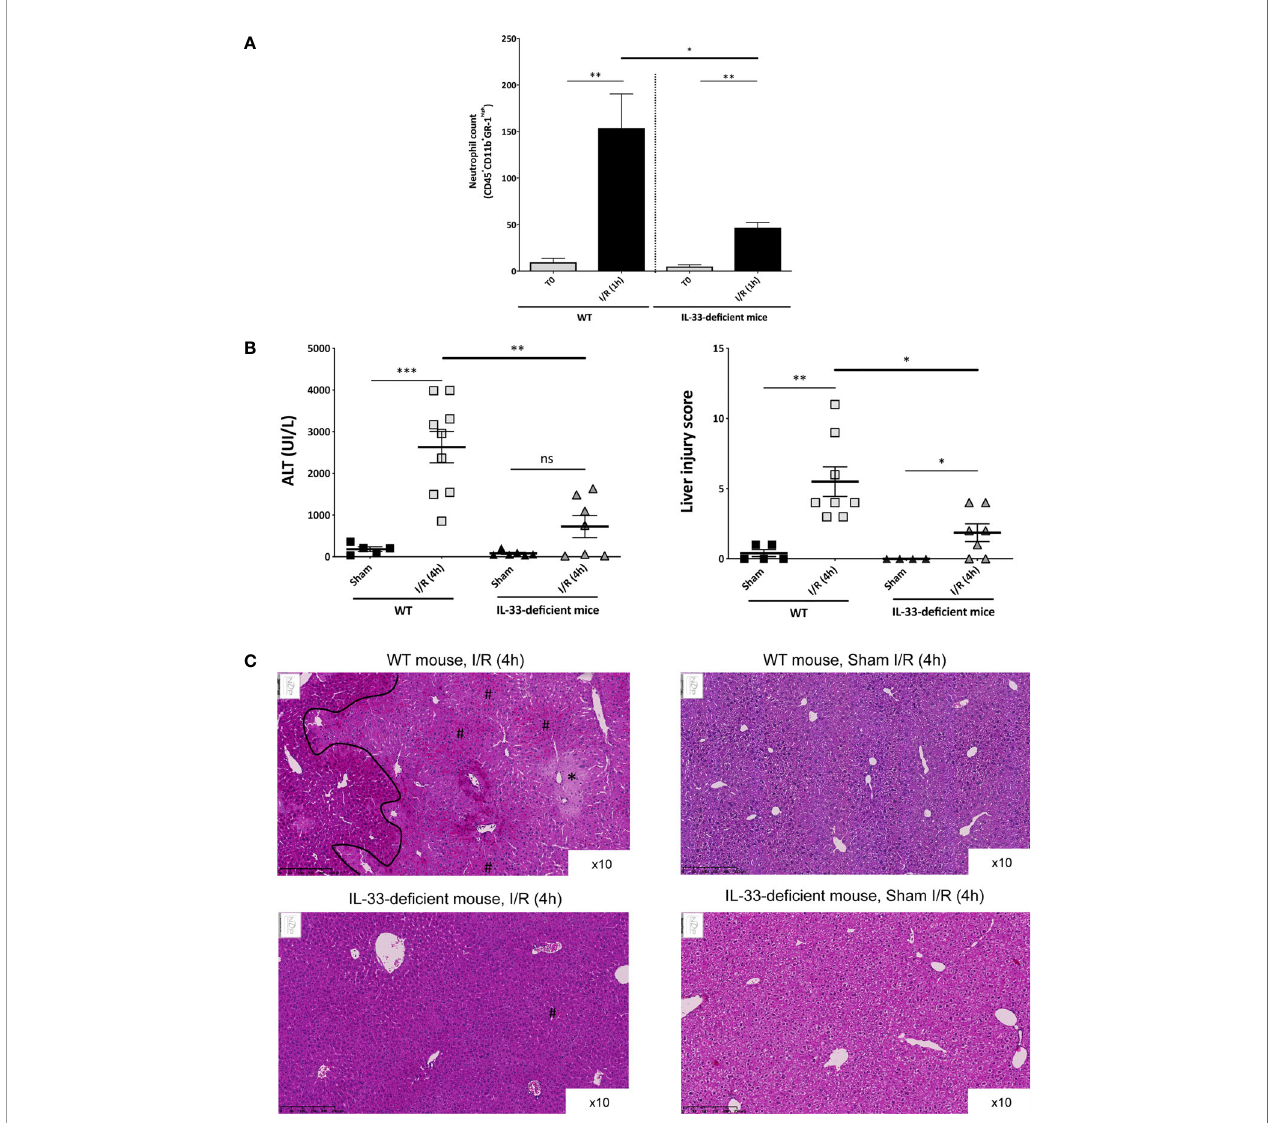
FIGURE 2 | Early recruitment of in fl ammatory cells and subsequent I/R injury after reperfusion depends on endogenous IL-33 and is responsible of I/R injury (mouse model). (A) Neutrophil count in the clamped liver lobes of WT and IL-33 – de fi cient mice, before clamping (T0) and after 1 h of reperfusion (I/R (1 h)). Immunoin fl ammatory cells were identi fi ed by fl ow cytometry, and results are displayed in absolute numbers per millgram of liver. Mean ± SEM, two-tailed Mann-Whitney U test, n = 4 – 11 mice per group. ns, not signi fi cant; * p < 0.05; ** p < 0.001. (B , left) Plasma levels of ALT (UI/L) in WT (left) and IL-33 – de fi cient mice (right) in Sham animals and after 4 h of reperfusion. Mean ± SEM, two-tailed Mann-Whitney U test, n = 5 – 9 mice per group. (B , right) Liver injury score in WT (left) and IL-33 – de fi cient mice (right) in Sham animals and after 4 h of reperfusion (I/R (4 h)). Mean ± SEM, two-tailed Mann-Whitney U test, n = 5 – 10 mice per group. (C) Tissue sections after paraf fi n embedding and HPS staining. (Top, left) Clamped liver of a WT mouse after 4 h of reperfusion at ×10 magni fi cation. *Shows an area with suffering hepatocytes; # shows an area with sinusoidal congestion and dilatation (red blood cells in sinusoidal spaces). On the left of the demarcation line, lesions are less intense. (Top, right) Liver of a Sham WT mouse at ×10 magni fi cation showing a normal liver. (Bottom, left) Clamped liver of an IL-33 – de fi cient mouse after 4 h of reperfusion at ×10 magni fi cation. There is no necrotic area; only some minor sinusoidal congestion can be identi fi ed (number sign). (Bottom, right) Liver of a Sham IL-33 – de fi cient mouse at ×10 magni fi cation showing a normal liver. ns, not signi fi cant; * p < 0.05; ** p < 0.001; *** p <